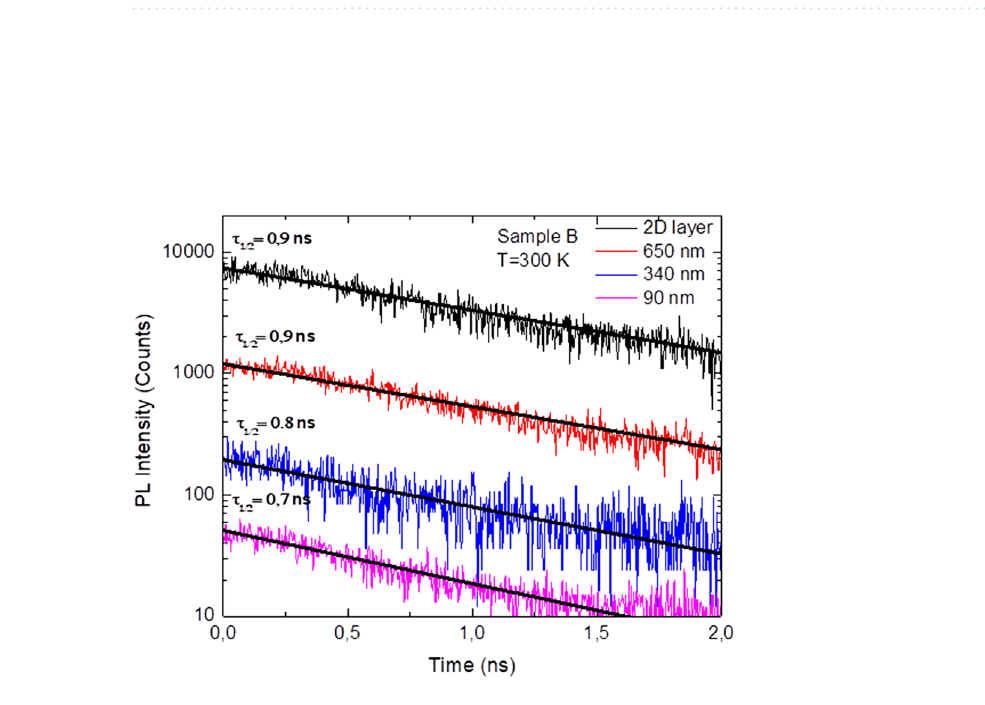
Figure 5. Time-resolved PL lifetime measurements at room temperature of sample B as a function of the diameter of the NRds and associated monoexponential fitting